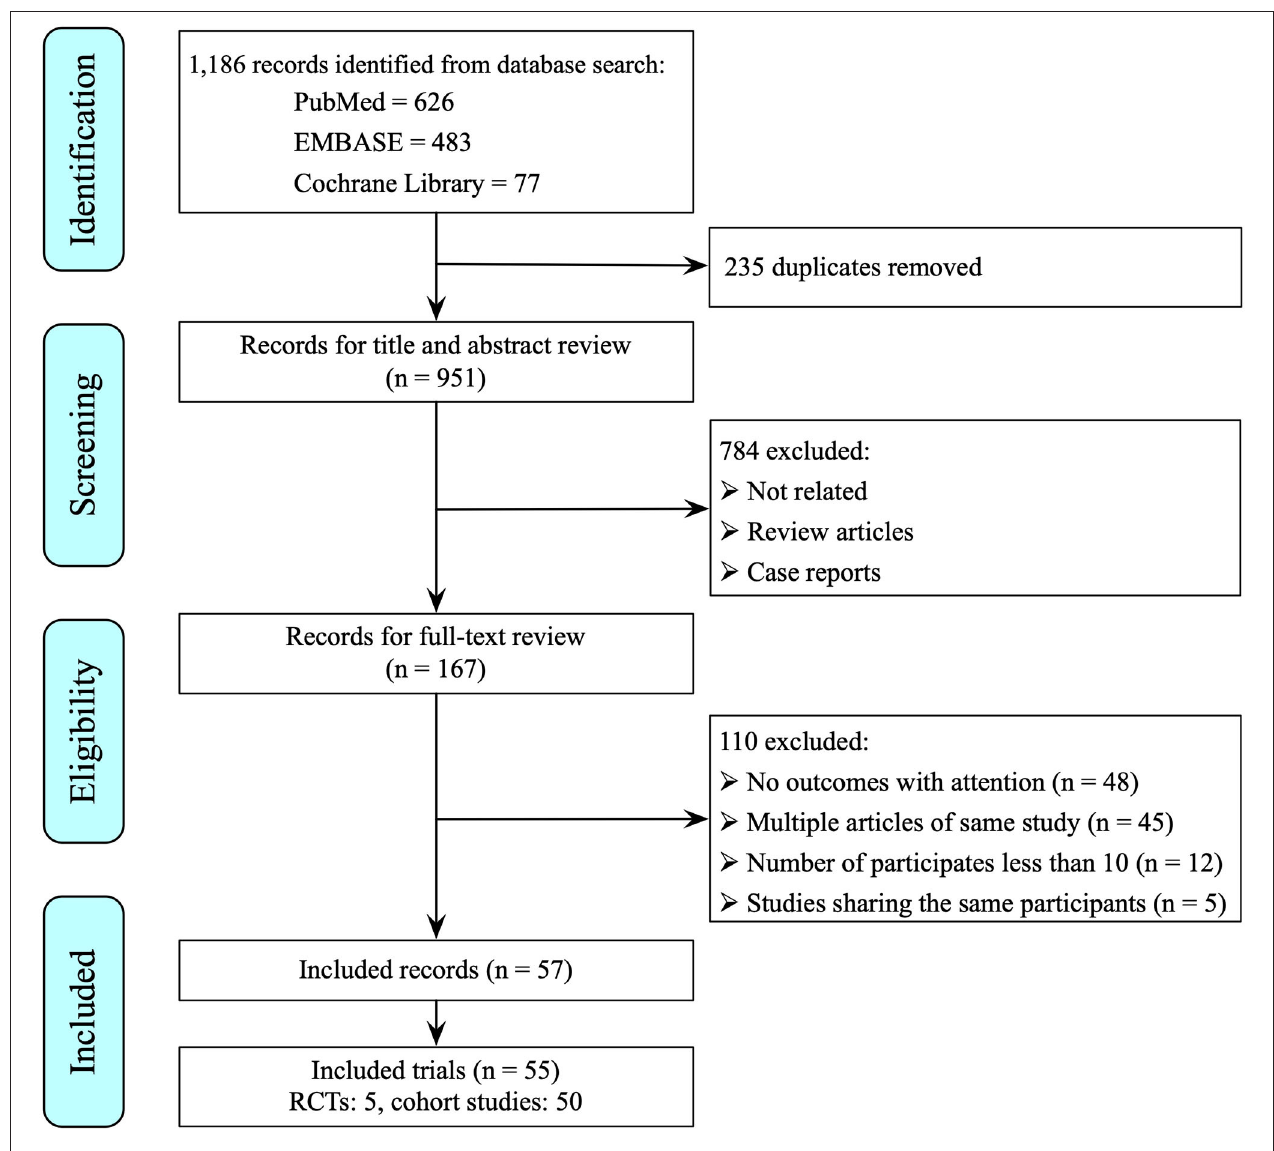
FIGURE 1 | Flow diagram describing the literature screening